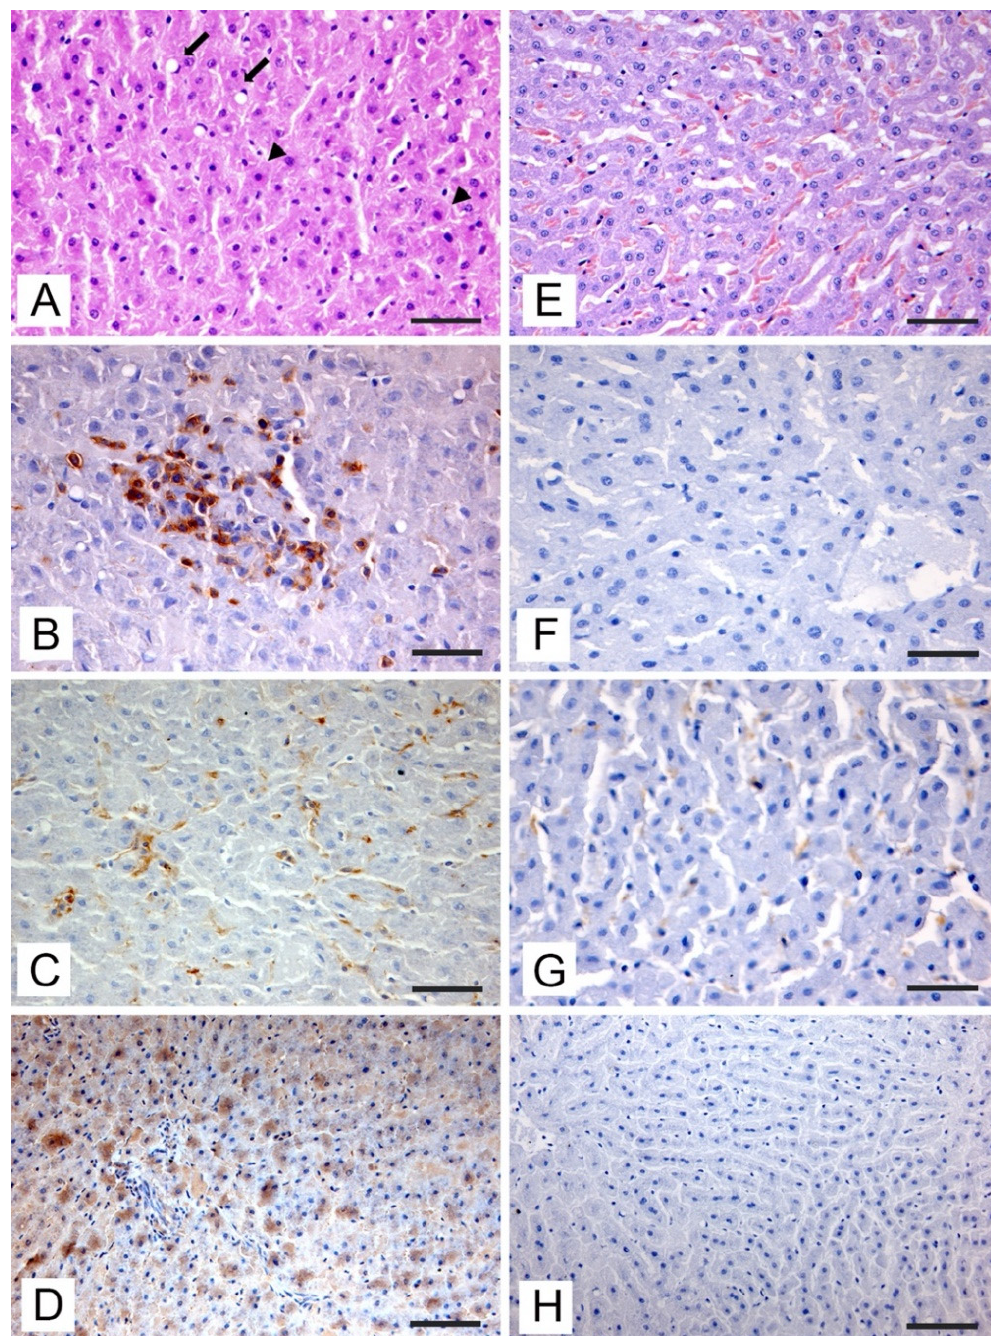
Figure 2. Liver tissue sections (pericentrilobular areas) from PCR-positive roe deer ( A – D ) and PCR- negative subject ( E – H ). ( A ) Focal area of degeneration with Ito cell hyperplasia (arrow) and single hepatocytes with nucleus loss and cytoplasmic hypereosinophilia (arrowheads) ( H , E , bar = 50 µ m). ( B ) CD3+ inflammatory infiltrate associated with degenerating hepatocytes (IHC, bar = 50 µ m). ( C ) Hyperplasia of Kupffer cells labeled with anti-Iba-1 (IHC, bar = 50 µ m). ( D ) Immunohistochemical staining with cytoplasmic pattern of hepatocytes incubated with anti-HEV antibody (IHC, bar = 100 µ m). ( E ) Normal hepatocytes in the pericentrilobular area ( H , E , bar = 50 µ m). ( F ) Absence of CD3+ lymphocytic infiltrate in hepatic sinusoids (IHC, bar = 50 µ m). ( G ) Scattered Kupffer cells labeled with anti-Iba-1 antibody (IHC, bar = 50 µ m). ( H ) Absence of immunostaining after incubation with anti-HEV antibody (IHC, bar = 100 µ m).